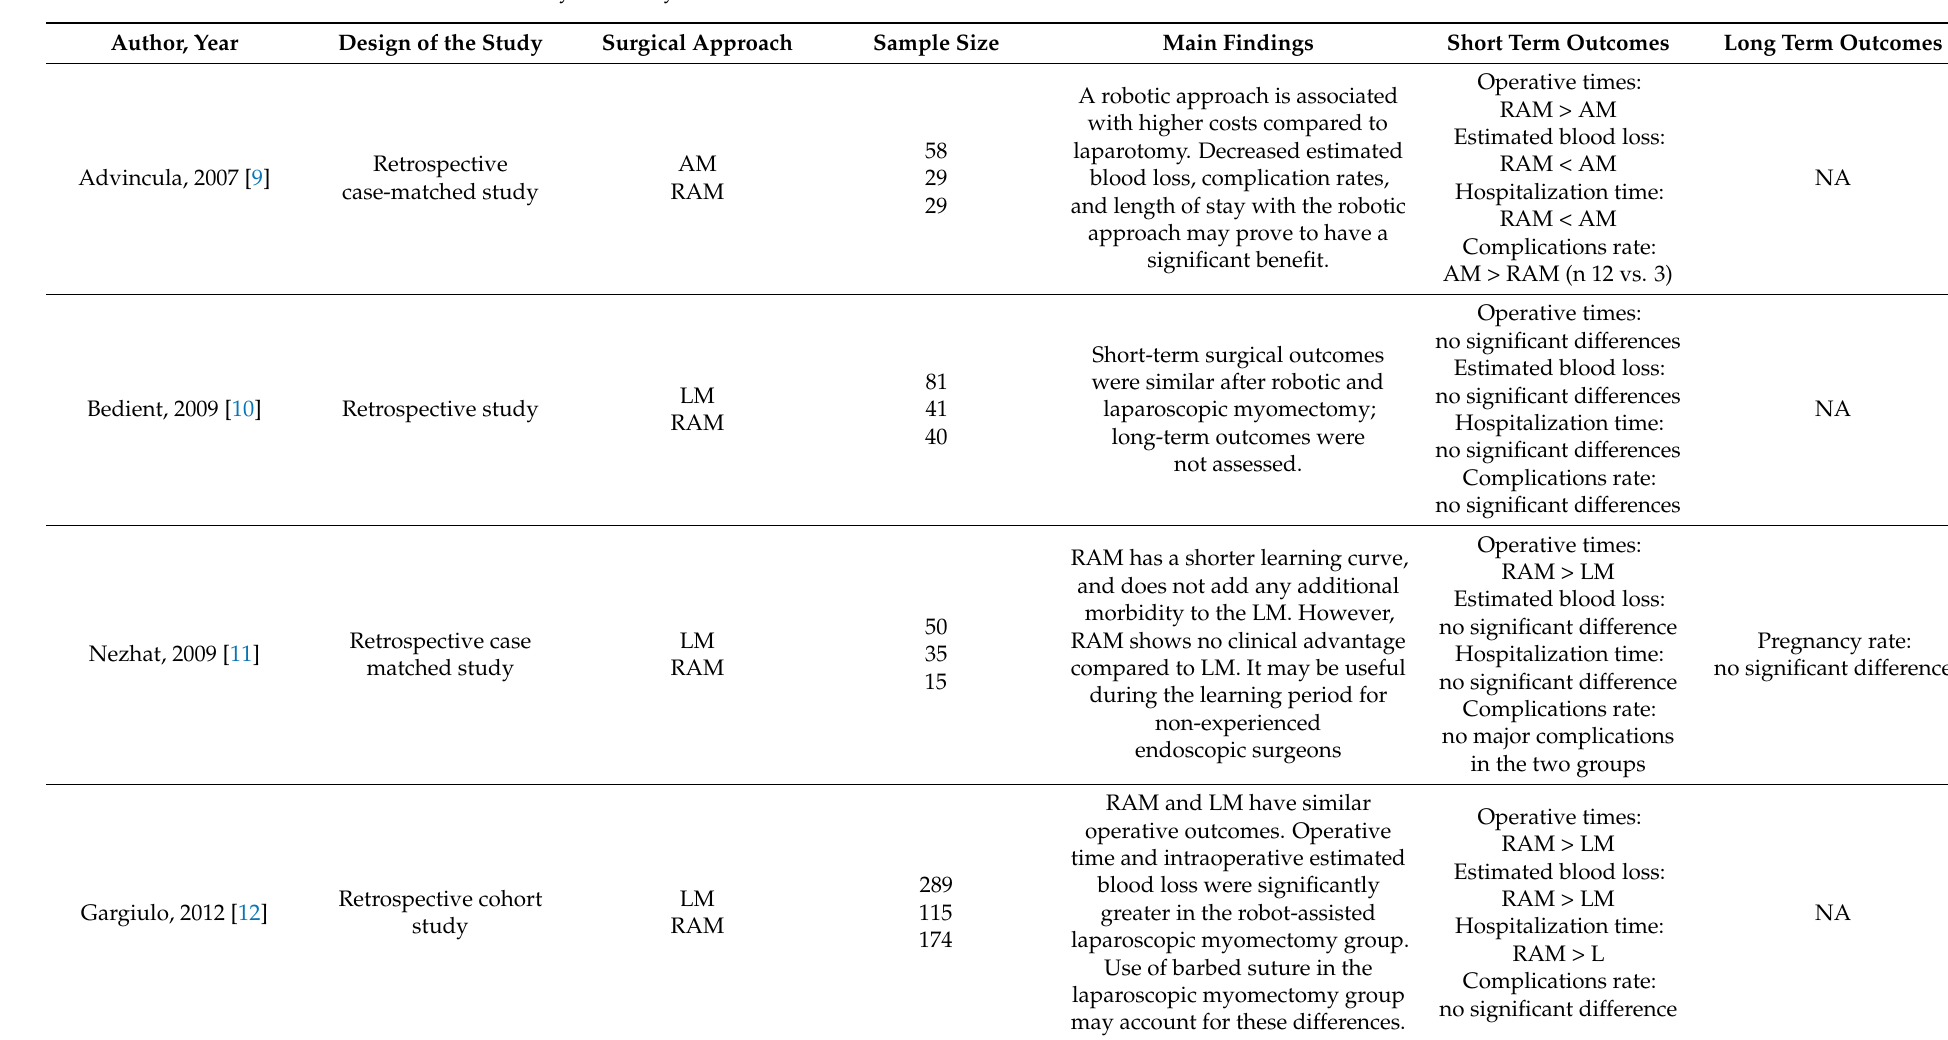
Table 1. Robotic Myomectomy